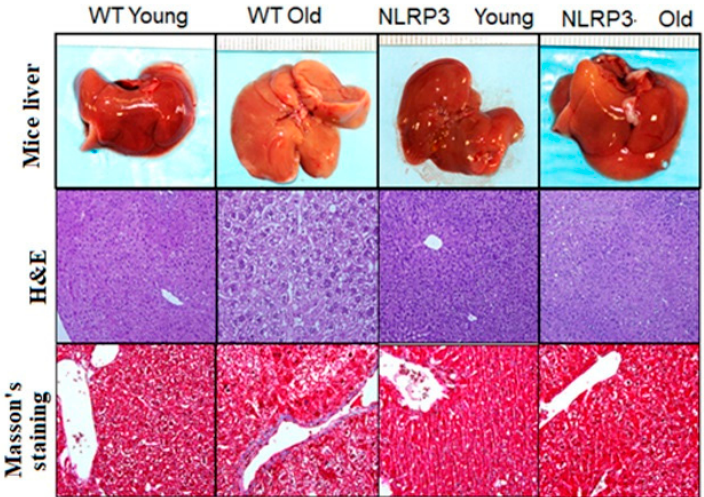
Figure 5. Representative liver sections. Upper: Liver mice; middle: H&E; lower: Masson’s trichrome staining.